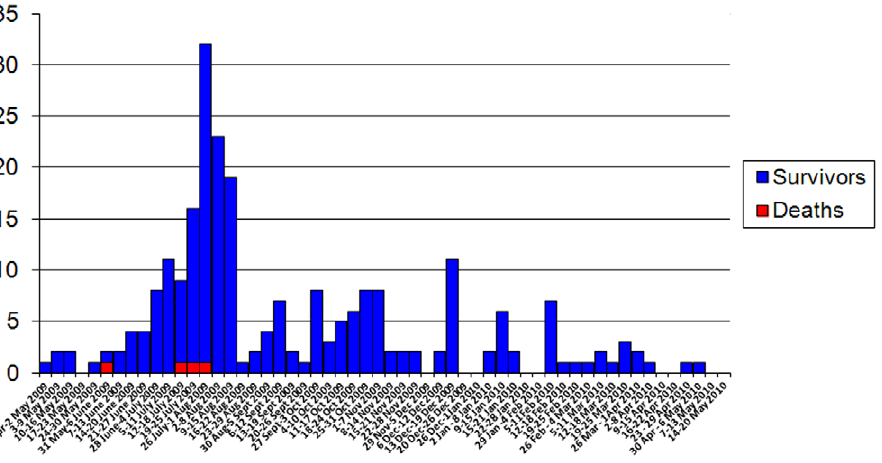
Figure 1. Cases and deaths from wet beriberi among AMISOM troops in Mogadishu, Somalia, by week of admission. n=241.